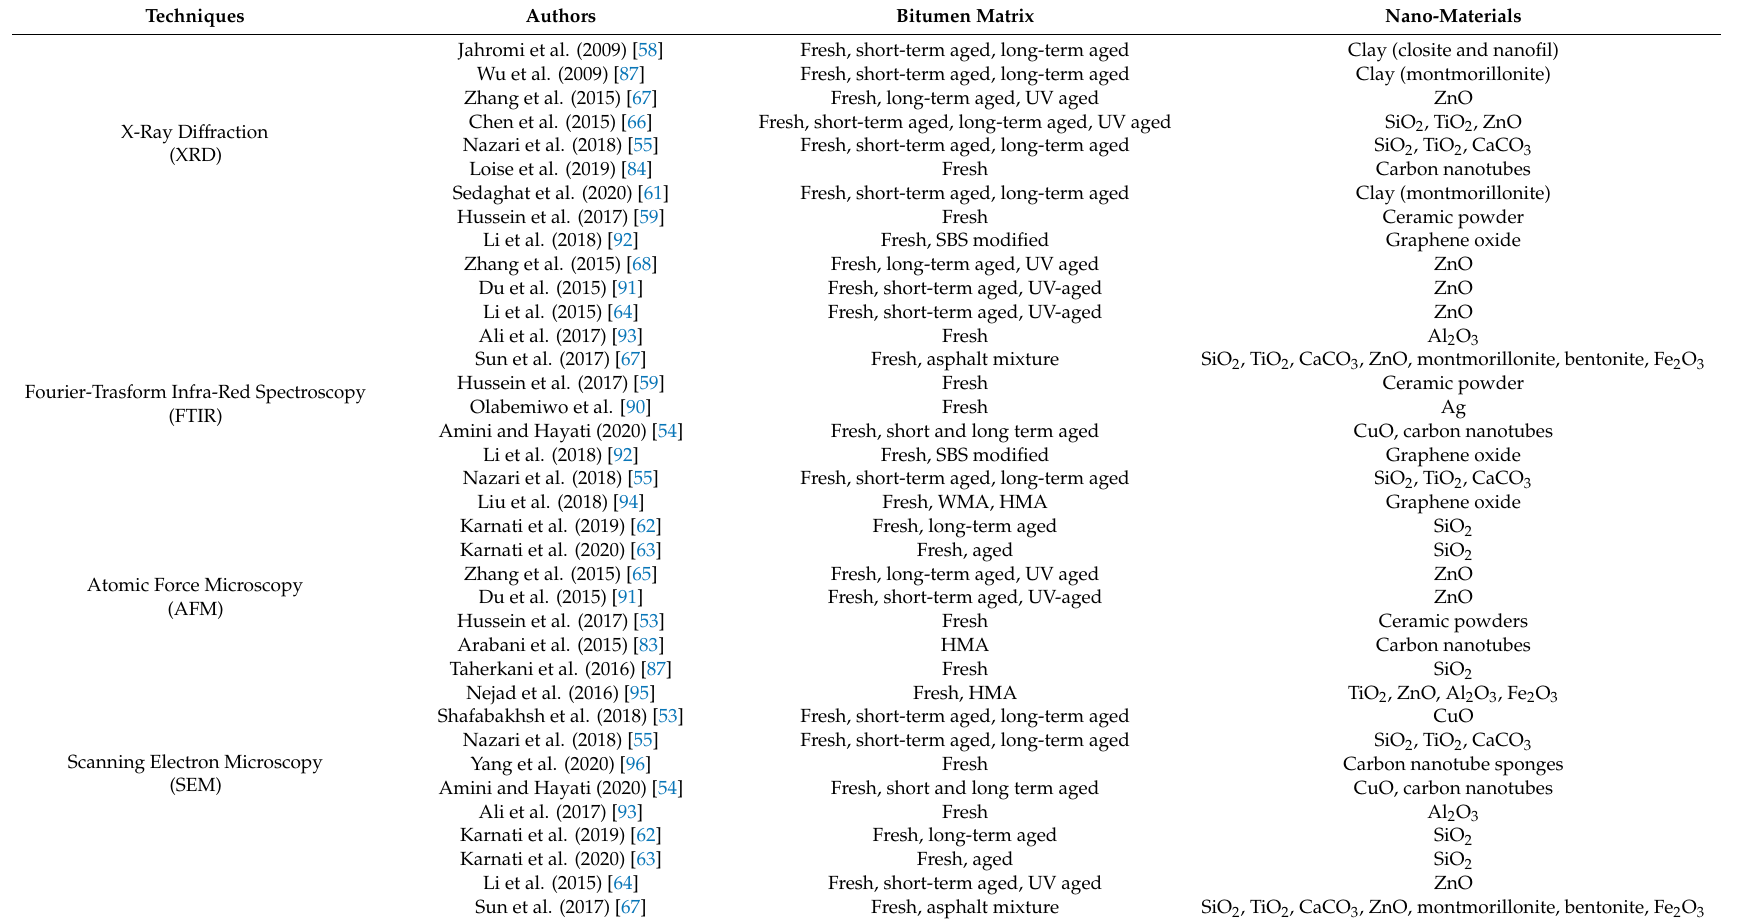
Table 3. A panoramic view of the techniques used for investigating nanoparticles-containing bitumens and